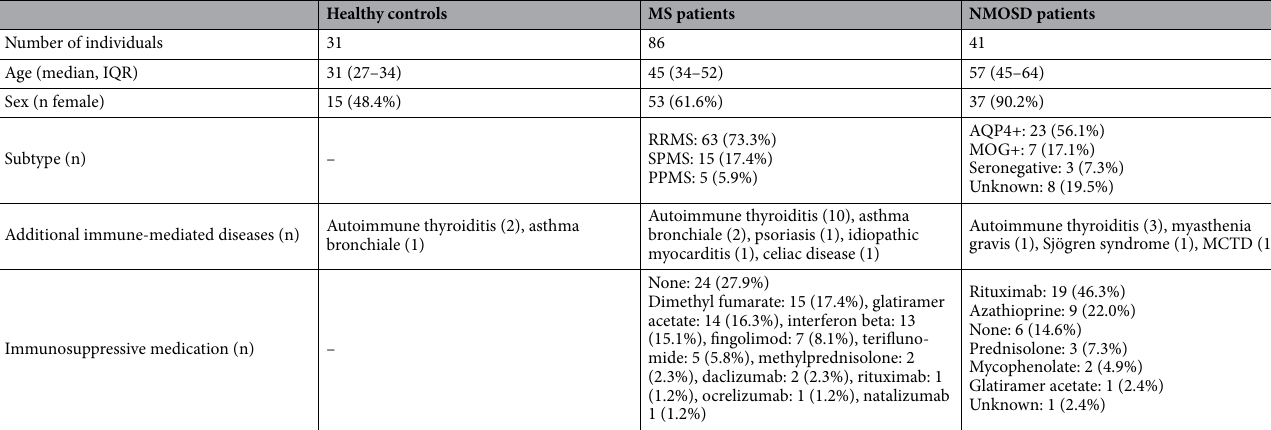
Table 1. Epidemiological data. IQR interquartile range, RRMS relapse-remitting multiple sclerosis, SPMS secondary progressive multiple sclerosis, PPMS primary progressive multiple sclerosis, AQP4 +